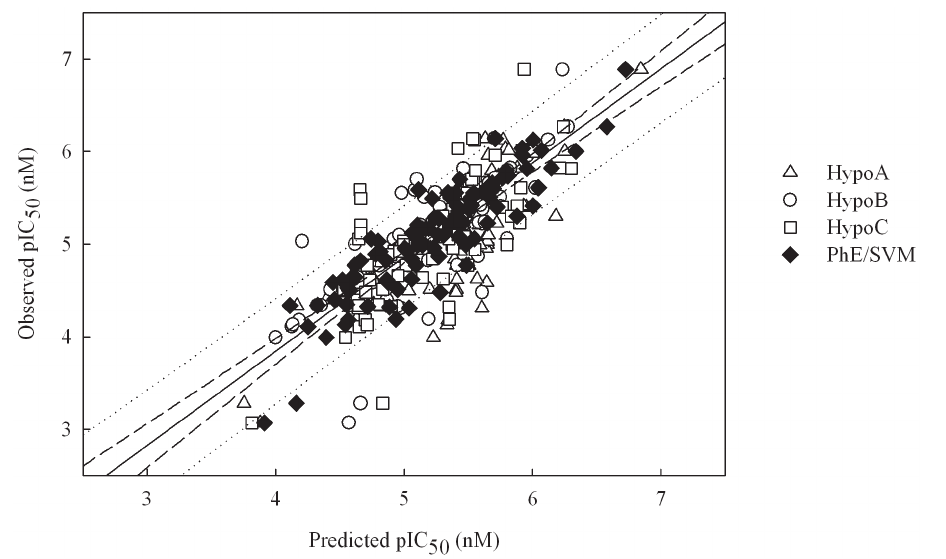
Figure 5. Observed vs . predicted pIC 50 values in the test set. Observed pIC 50 vs . the pIC 50 predicted by Hypo A, Hypo B, Hypo C, and PhE/SVM for those molecules in the test set. The solid line, dashed lines, and dotted lines correspond to the PhE/SVM regression of the data, 95% confidence interval for the PhE/SVM regression, and 95% confidence interval for the prediction, respectively.